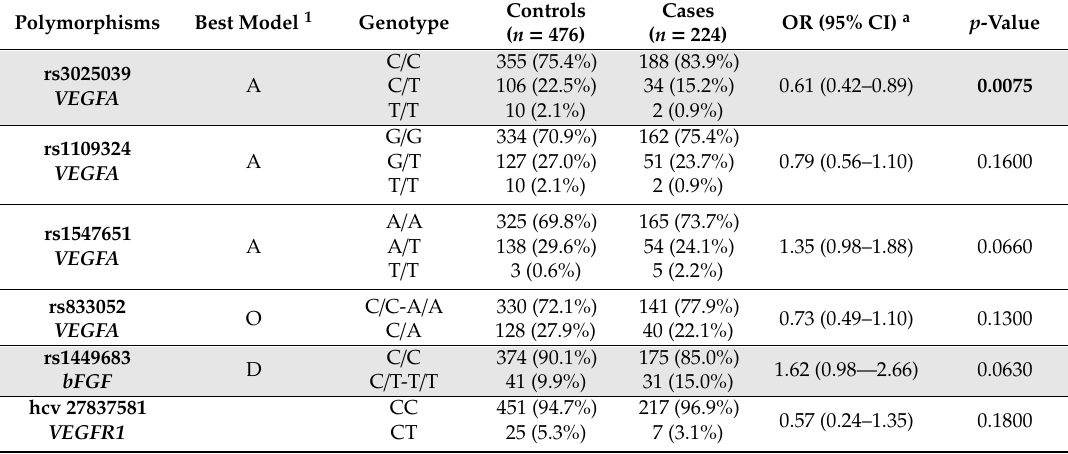
Table 3. Genotypic and allelic frequencies of VEGF , VEGFR1 and bFGF polymorphisms and B-chronic lymphocytic leukemia